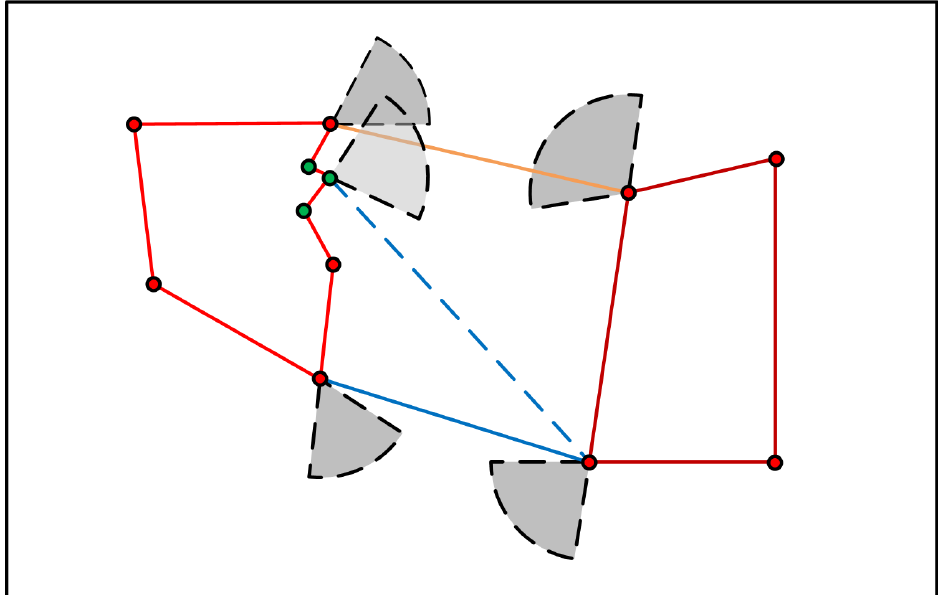
Figure 11. An illustration of sparse v-graph. The edge (orange) that head into at least one polygon from the shaded angle are eliminated, and the blue one will be kept. After eliminating those green vertices, the dot blue edge will be removed from the G local